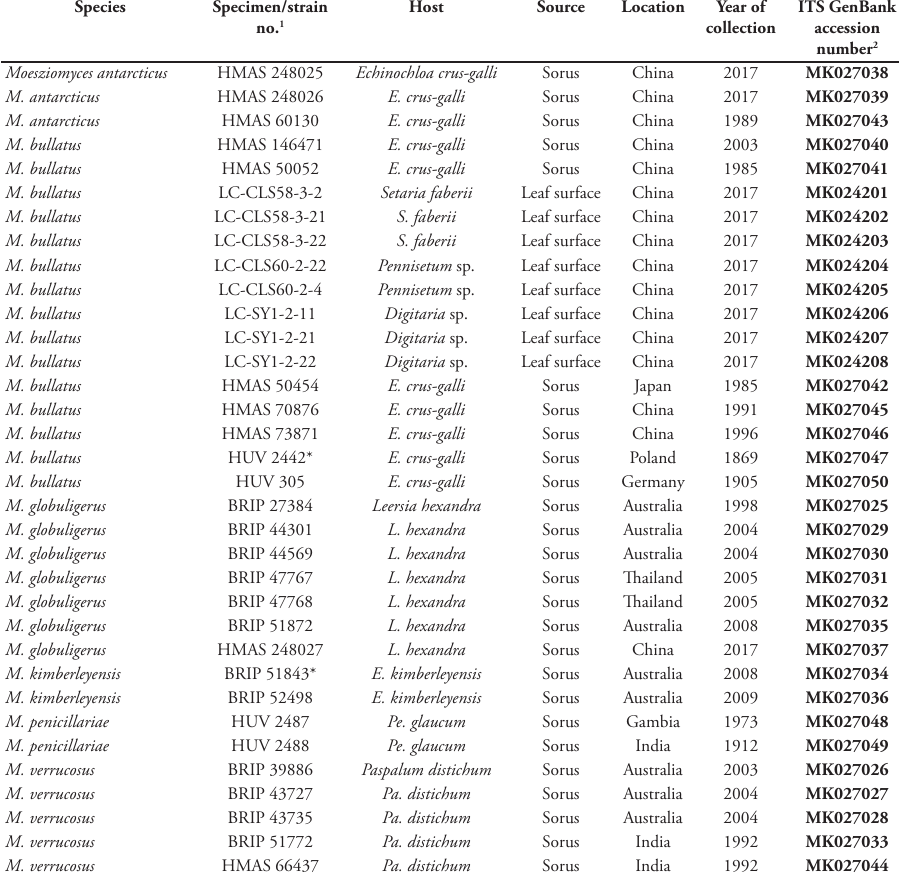
Table 1. Collection details for Moesziomyces specimens newly sequenced in this study. Species Specimen/strain no. 1